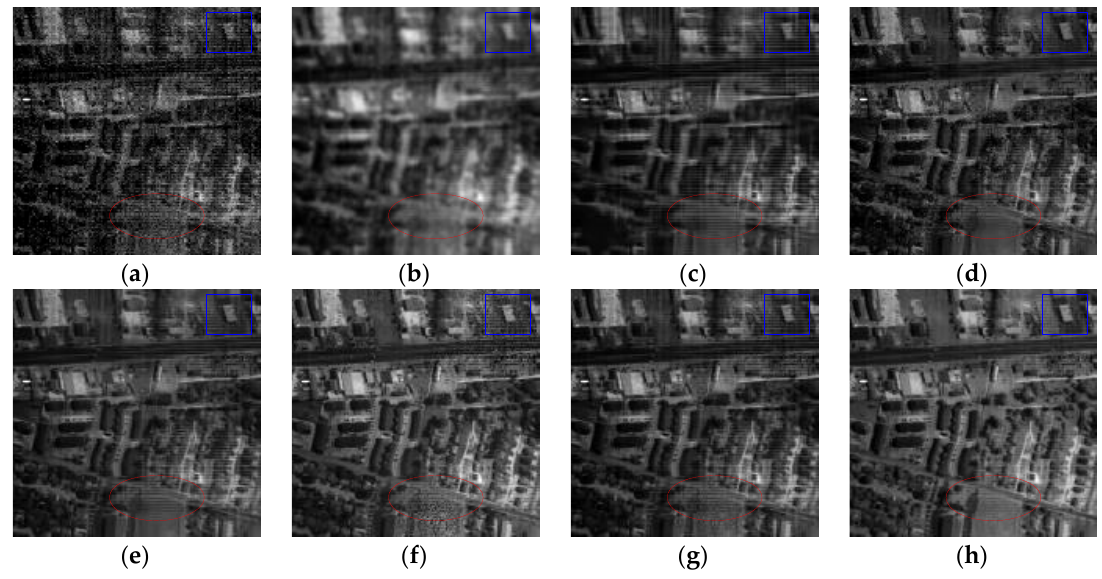
Figure 15. × 4 magnified results of the various approaches in the red rectangle of Figure 14: ( a ) Original band 186; ( b ) KSVD; ( c ) BM3D; ( d ) ANLM3D; ( e ) BM4D; ( f ) LRMR; ( g ) DDL3+FT; ( h ) Our method.